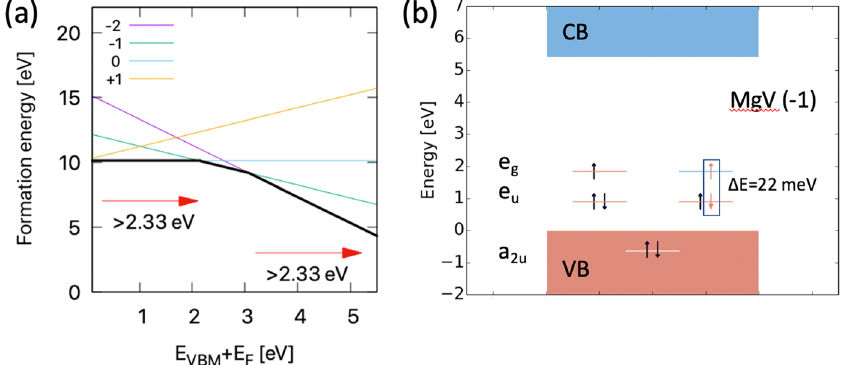
Fig. 1 Ground state properties of MgV color center in diamond. a A formation energy diagram for the MgV defect, where 2.33 eV indicates the energy of the green laser pulse. b A schematic representation of the electronic structure for the MgV( − ). Here, the coexistence of two possible ground states, separated by 22 meV, is depicted by a respective spin- fl ip